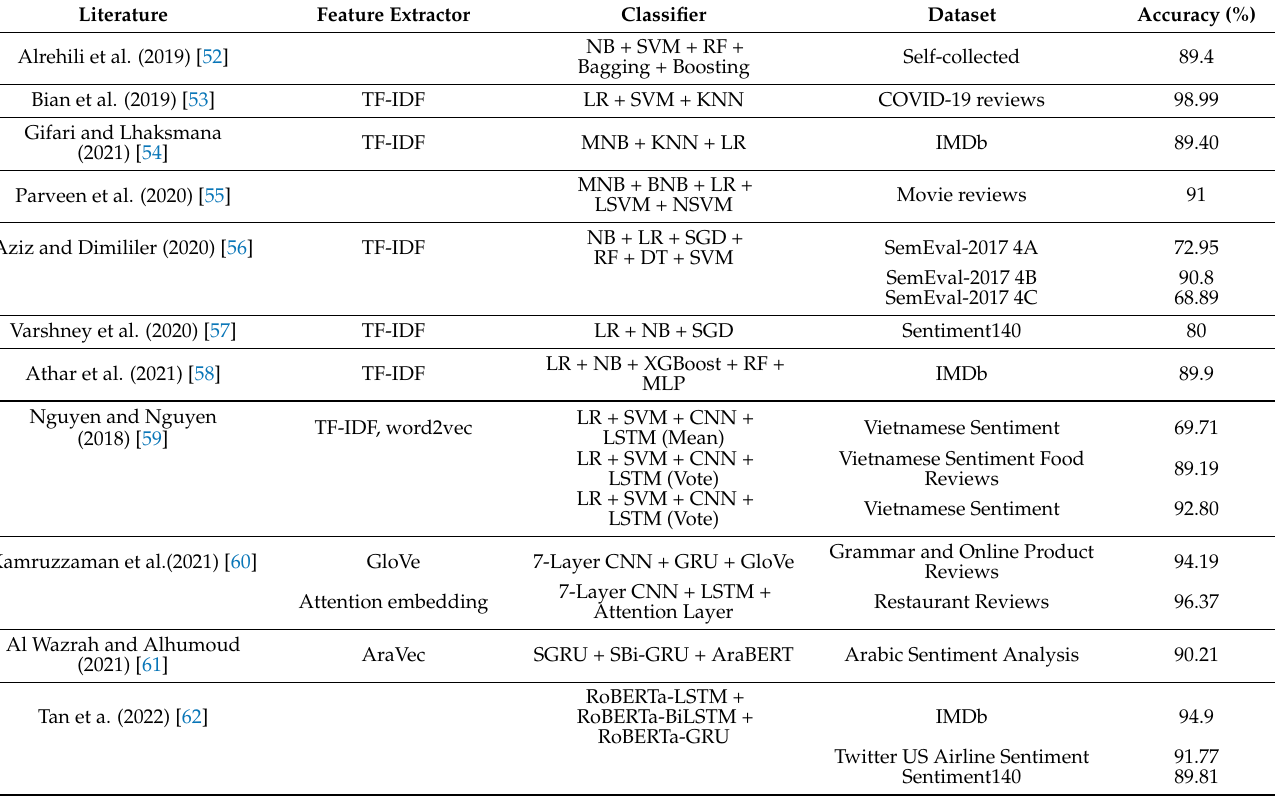
Table 3. Summary of ensemble learning